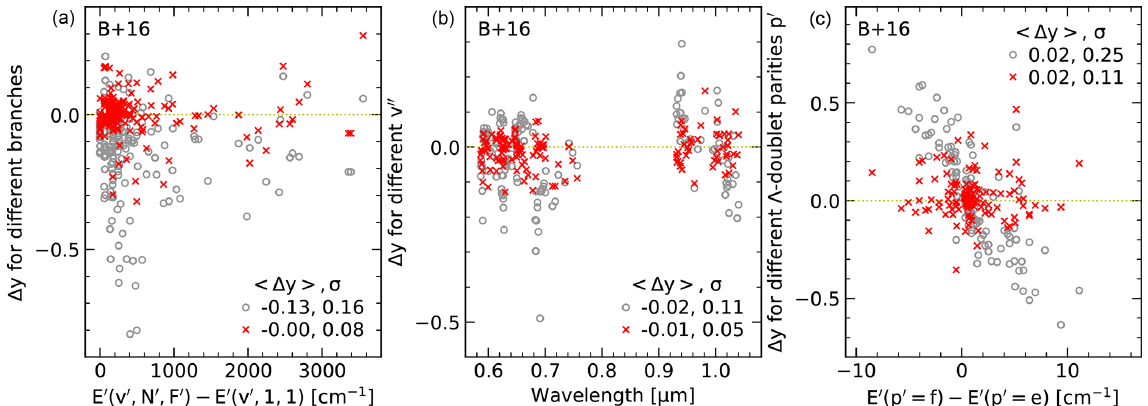
Figure 11. Correction of Brooke et al. (2016) Einstein- A coefficients. The measured (circles) and corrected (crosses) OH level population ratios, (cid:49)y , are given for changes in the branch ( a ; cf. Fig. 6), lower vibrational level v (cid:48)(cid:48) ( b ; cf. Fig. 8), and the (cid:51) -doublet component ( c ; cf. Fig. 9). Each plot lists the mean (cid:49)y and standard deviation σ for the measured and corrected data.